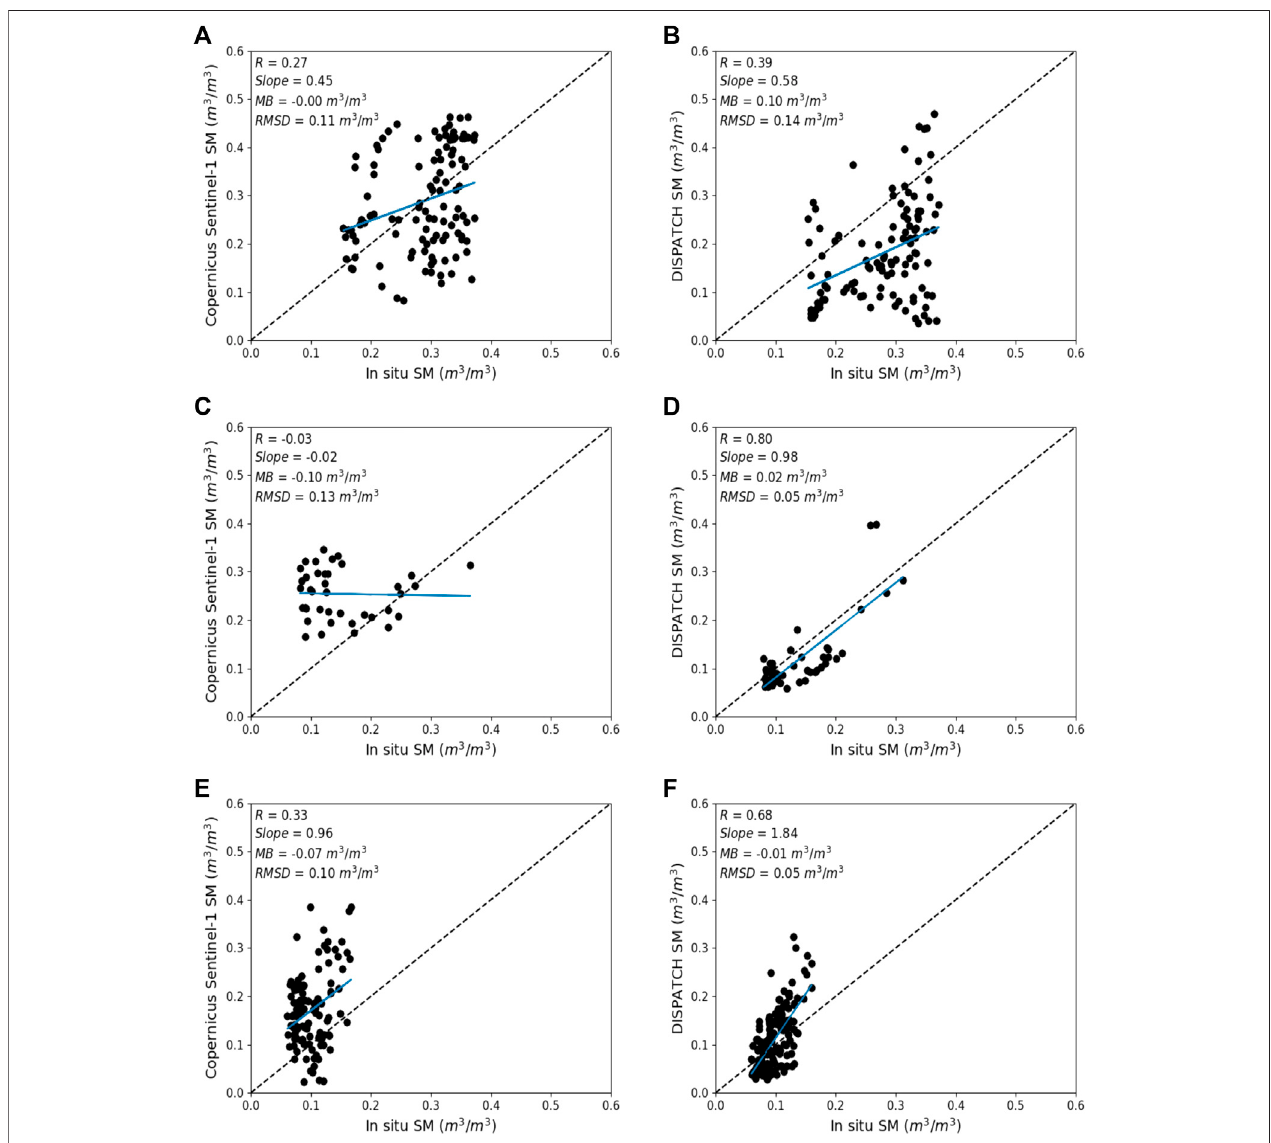
FIGURE 8 | Scatterplot of Copernicus Sentinel-1 vs. in situ SM (left) and DISPATCH veg – ext vs. in situ SM (right) for Auradé (ICOS) site, 2018 (A,B) ; HA1 (dryland) site, 2019 (C,D) and L03 (REMEDHUS) site, 2017 (E,F) .